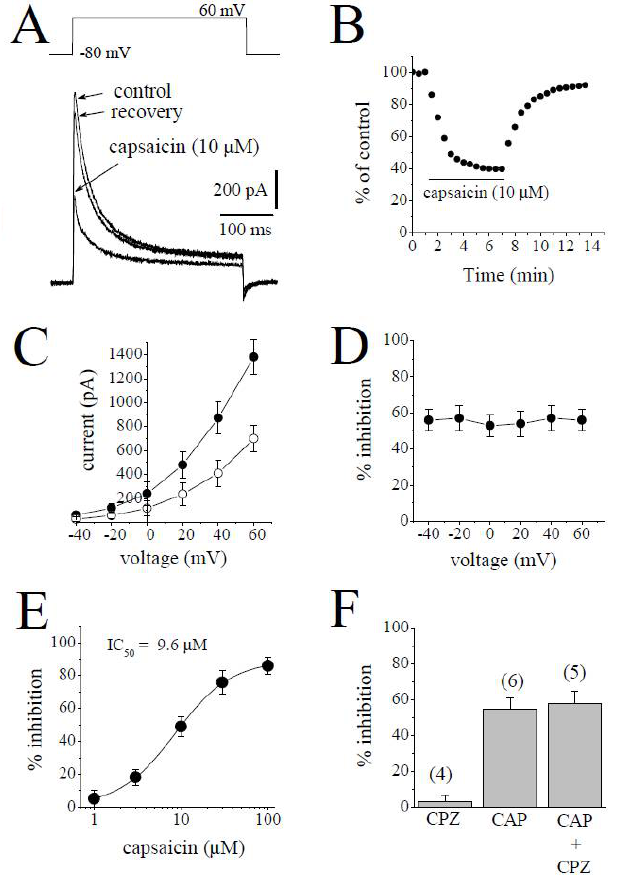
Figure 5. The effects of capsaicin on the transient outward I to in rabbit ventricular myocytes. ( A ) Traces of I to obtained in response to depolarizations from a holding potential of −80 mV to +60 mV are presented in control after 6 min exposure to 10 µM capsaicin and recovery. The pulse protocol to activate I to is presented as an inset. ( B ) Time course of the effect of capsaicin effect on the maximal amplitudes of I to and washout presented as % of control calculated from the mean of three control currents. ( C ) Current–voltage relationships of I to in absence (filled circles) and presence (open circles) of 10 µM capsaicin are shown ( n = 5). ( D ) The relationship between test potential and the capsaicin (10 µM) inhibition of I to ( n = 5; p > 0.05, ANOVA). ( E ) Concentration–inhibition of capsaicin for I to ( n = 4–7). ( F ) The effect of capsazepine (3 µM) and the extent of capsaicin (10 µM) inhibition of I to in the absence and presence of 3 µM capsazepine. The number of cells tested for each group was presented on top of each bar ( p > 0.05; t -test).